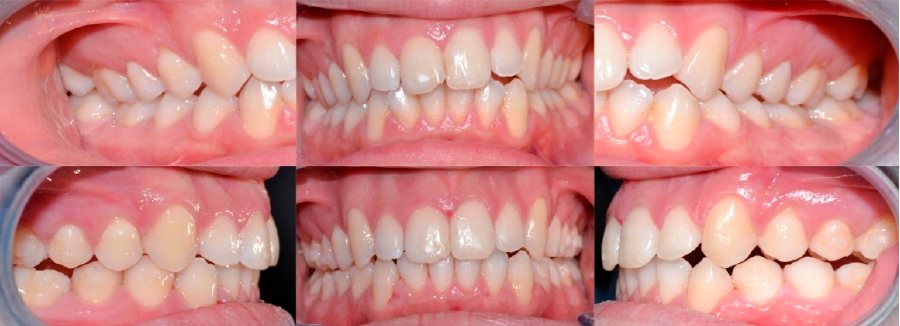
Figure 4. Case 1: initial and final frontal and lateral photo.